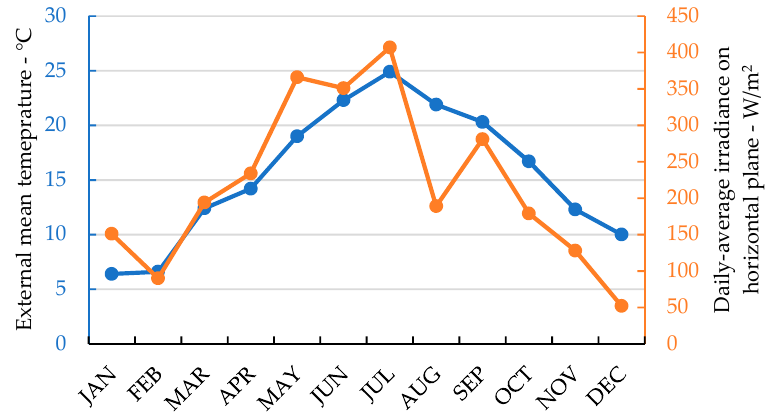
Figure 2. Average monthly temperature and daily irradiance on horizontal plane.